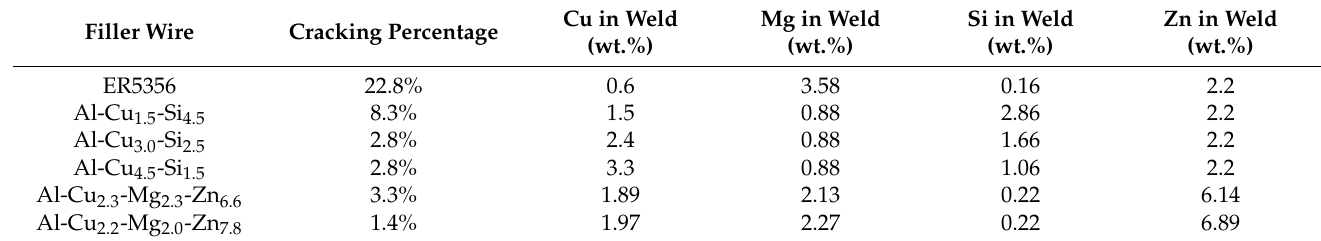
Table 2. Liquation cracking susceptibility and compositions of welds.